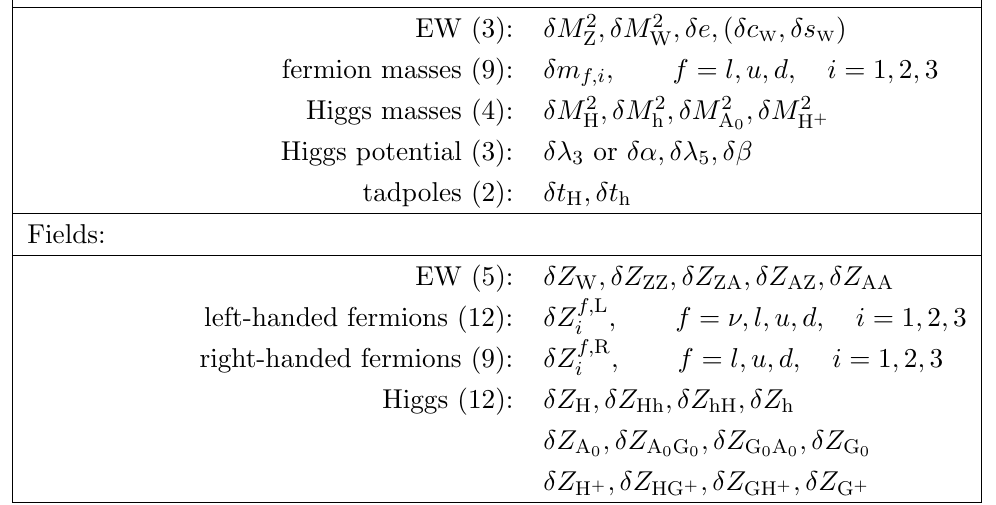
Table 3 . The renormalization constants used to describe the THDM, separated into sectors of parameter and (cid:12)eld renormalization. The renormalization constants in parentheses are not in- dependent, but useful for a better bookkeeping. The numbers in parentheses are the numbers of independent renormalization constants. In total there are 38 (cid:12)eld and 21 parameter renormalization constants to